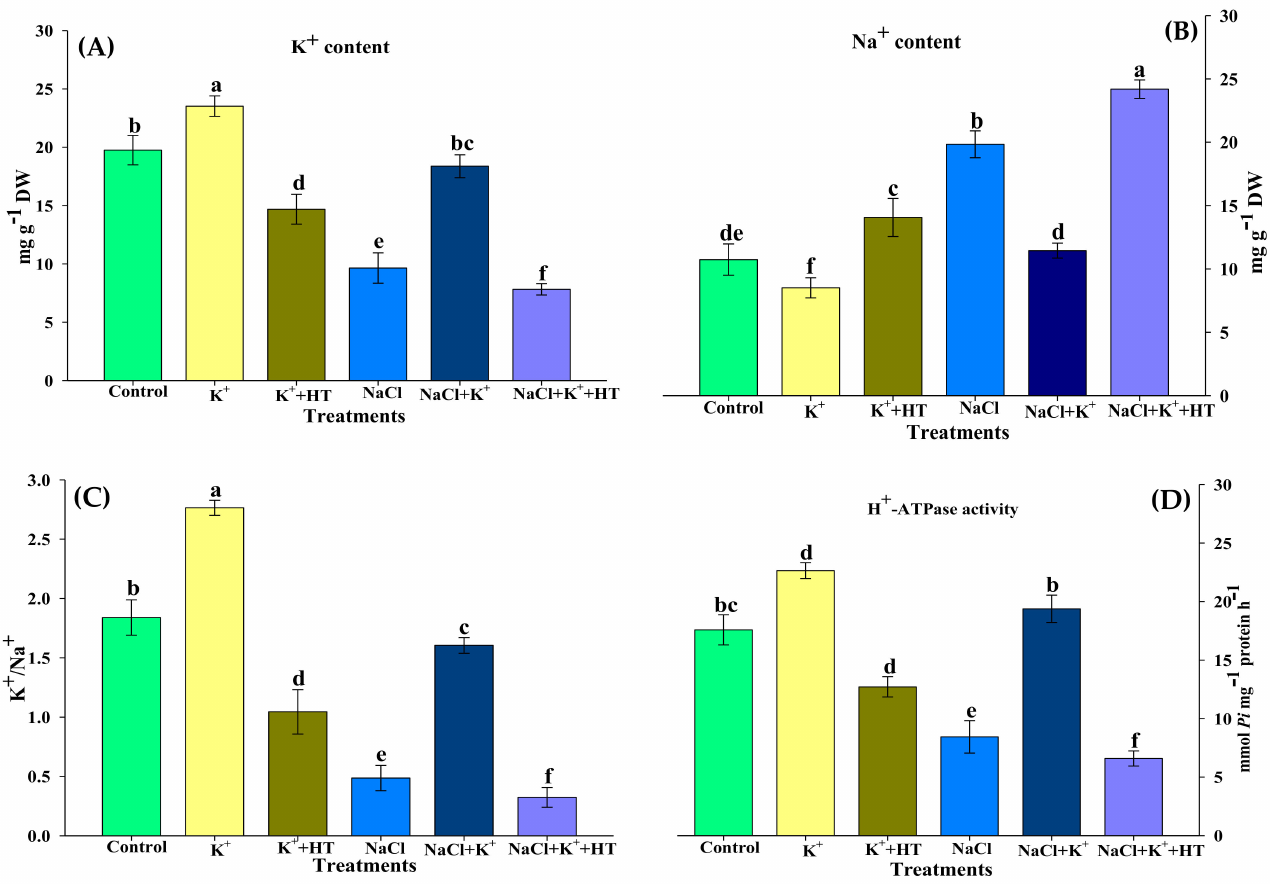
Figure 2. Effect of K + and NaCl on K + and Na + concentration and H + -ATPase activity in the roots of tomato seedlings. ( A ) K + content, ( B ) Na + content, ( C ) K + /Na + ratio, and ( D ) H + -ATPase activity. Double deionized water (control), 5 mM K 2 CO 3 (K + ), 100 mM NaCl (NaCl), 1 mM hypotaurine (HT: H 2 S scavenger). Values are means of five independent replicates, with bars indicating SE. Bars with different letters indicate that differences were statistically significant at p < 0.05